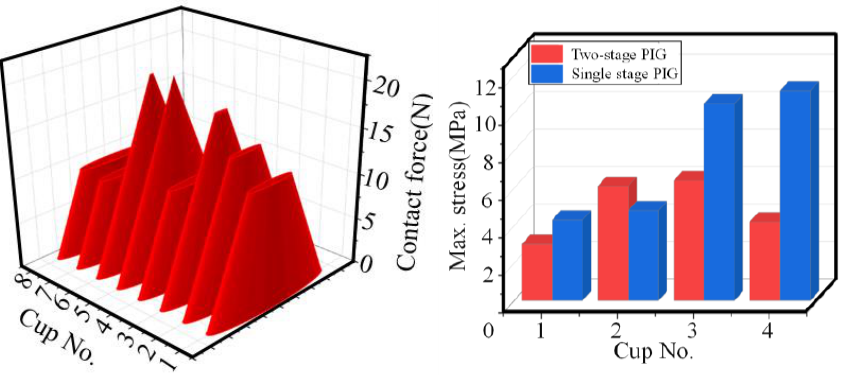
Figure 13. Comparison of the maximum stress of each numbered leather cup and the contact force of the previous numbered leather cup.